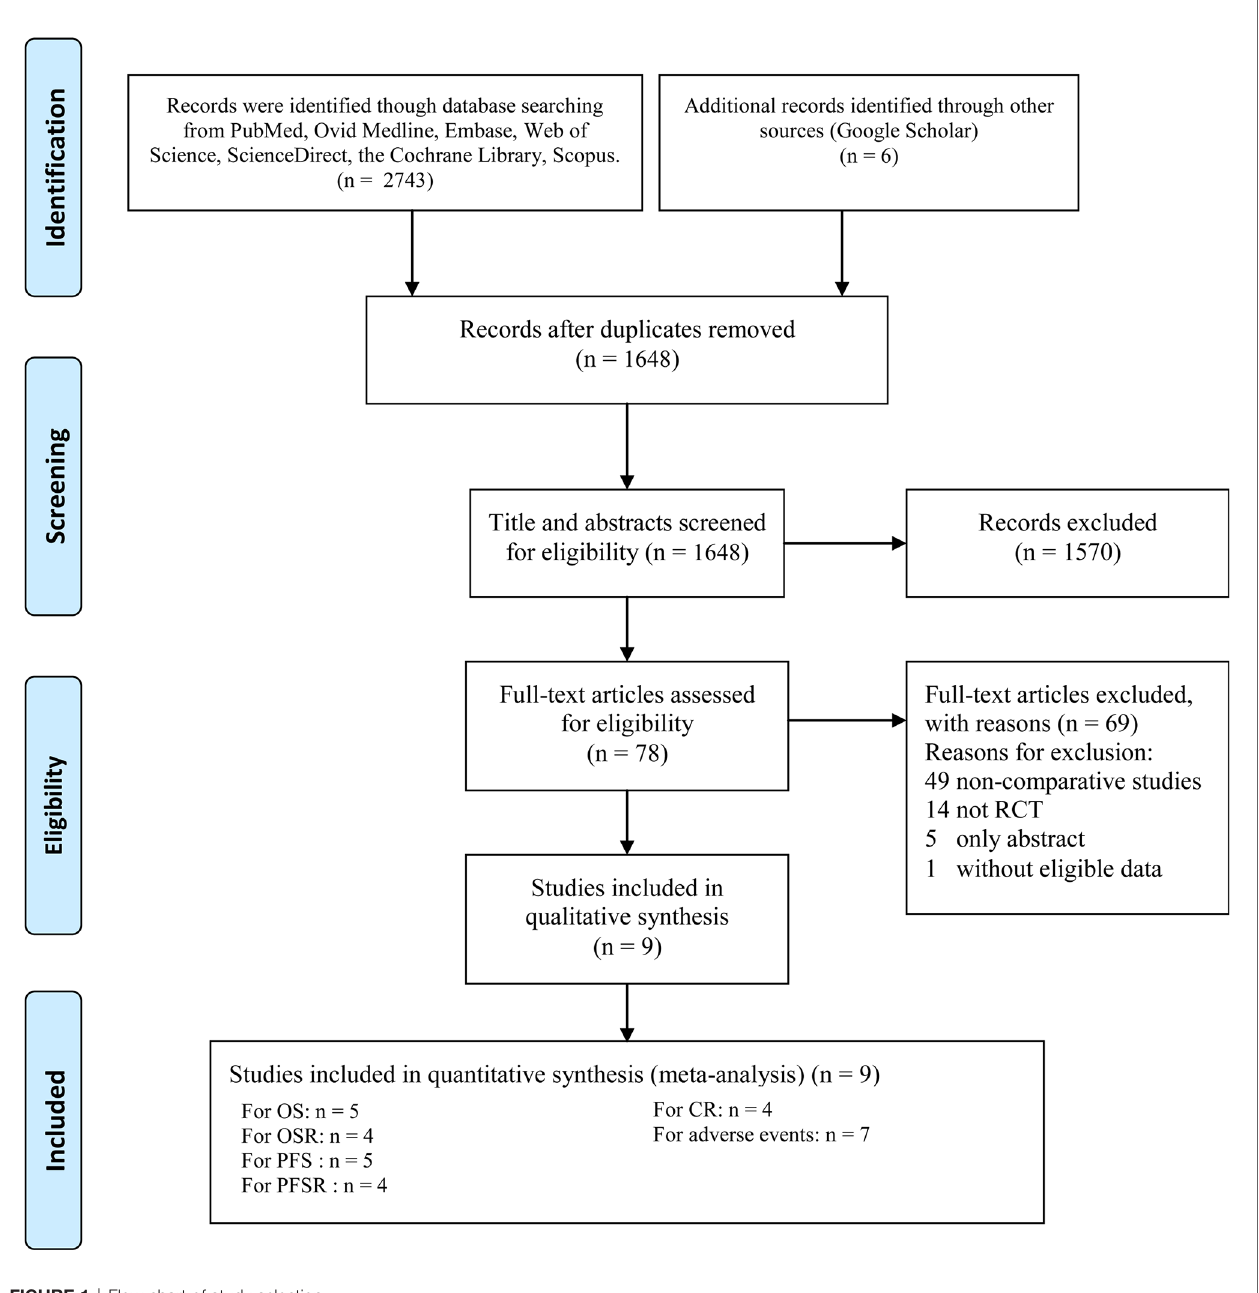
FIGURE 1 | Flow chart of study